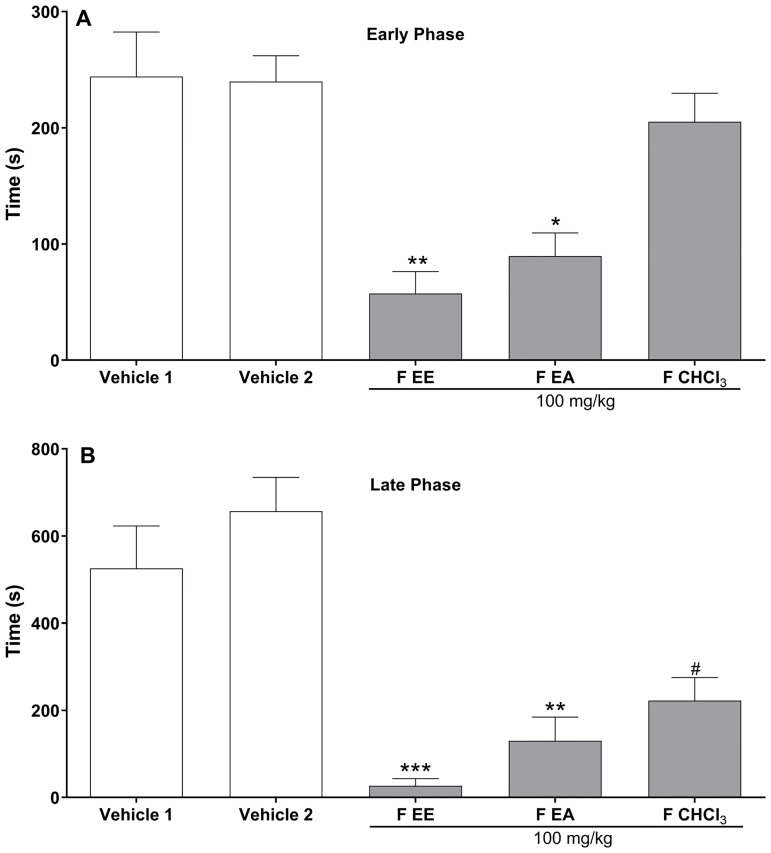
Effects of different fractions from methanol extract of D. vandellianum leaves (ME) on formalin test in mice.Mice were treated with vehicle (control groups) or fractions (100 mg/kg) by intraperitoneal route 40 min before the intraplantar injection of formalin (injected at time zero). FEE: ether fraction from ME (solubilized in saline); FEA: ethyl acetate fraction from ME (solubilized in 5% DMSO); FCHCl3: chloroform fraction from ME (solubilized in 5% DMSO). Vehicle 1: saline (control group of FEE). Vehicle 2: 5% DMSO plus saline (control group of FEA and FCHCl3). Mice were observed from 0 to 10 min (early phase; A) and from 10 to 30 min (late phase; B), and a nociceptive score was determined for each period by counting the time in seconds that the animal spent licking the injected limb during the observation time. Data are expressed as mean times ± S.E.M.; n = 6 mice per group. * Significantly different from vehicle 1 group (p < 0.05); **significantly different from vehicle 1 group (p < 0.01); *** significantly different from vehicle 1 group (p < 0.001); # significantly different from vehicle 2 group (p < 0.01). ANOVA followed by Tukey’s test.